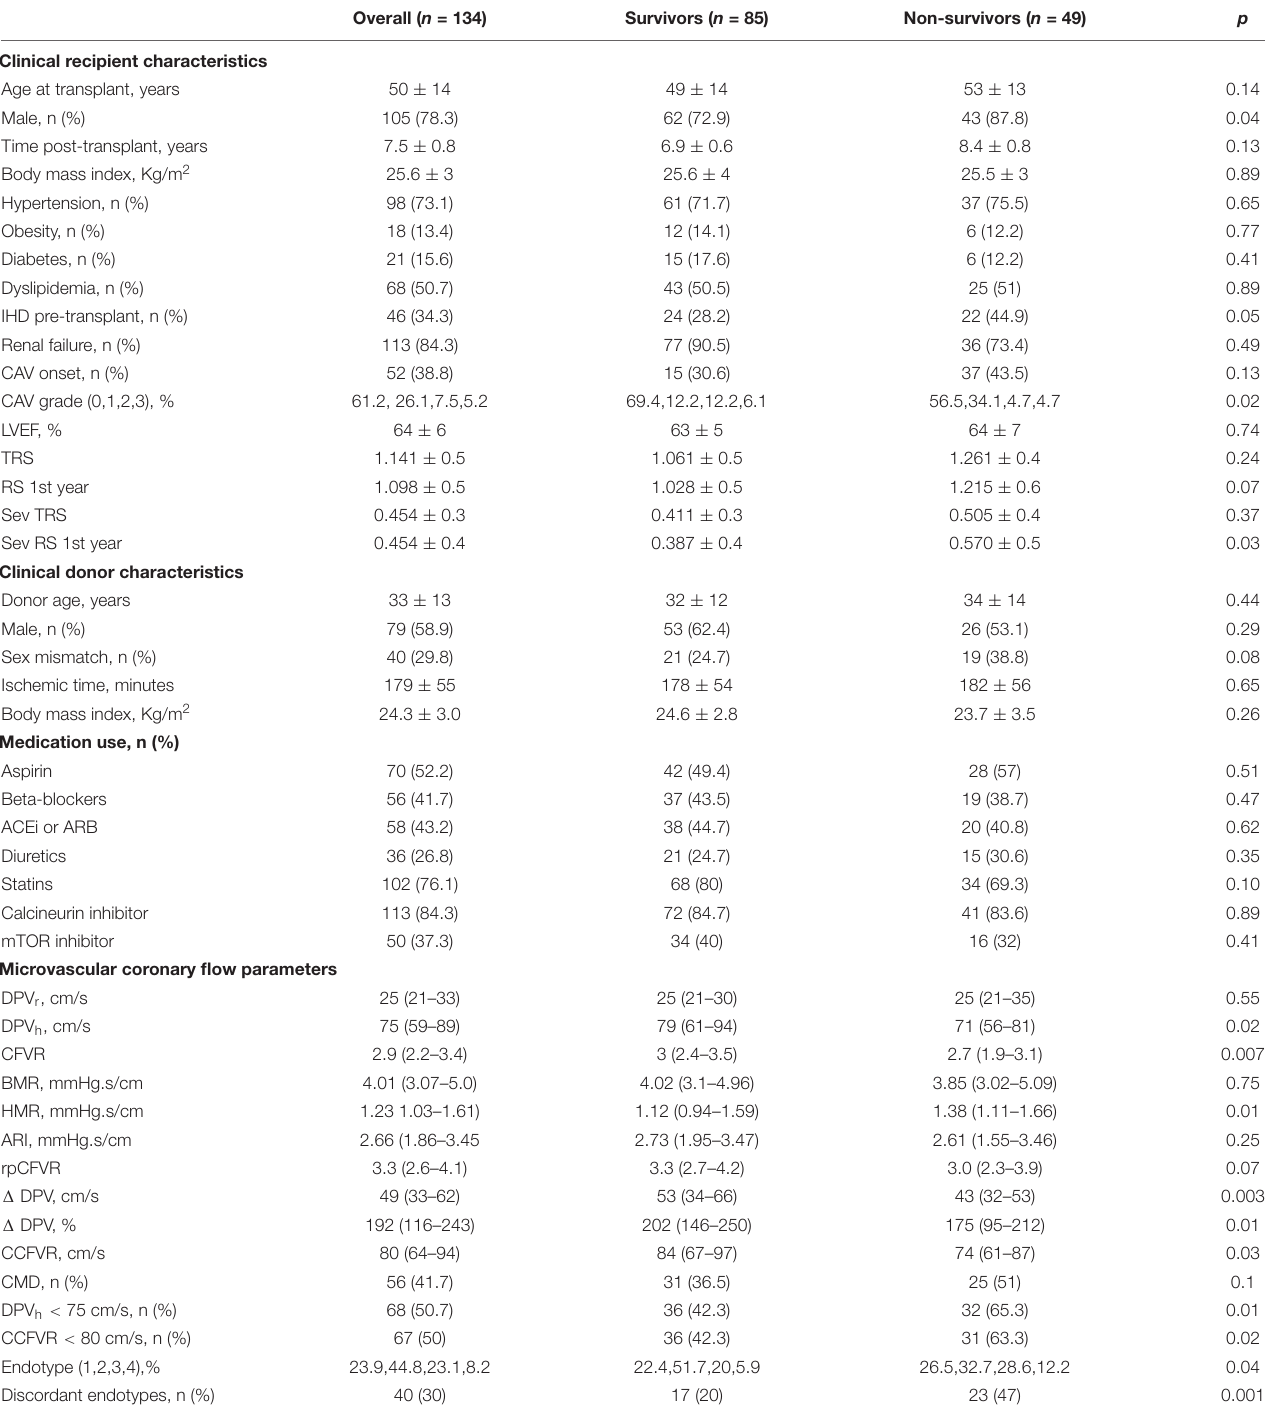
TABLE 4 | Clinical, hemodynamic and microvascular coronary flow parameters in survivors and non-survivors heart transplant patients. Overall ( n = 134) Survivors ( n = 85) Non-survivors ( n = 49)